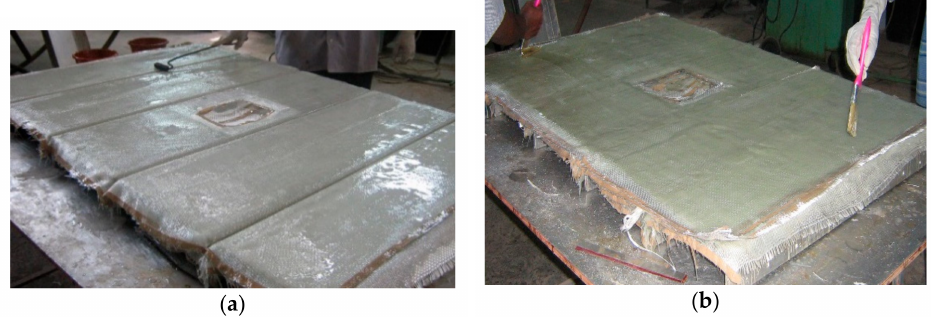
Figure 4. Casting of GFRP-stiffened composite plates. ( a ) Laying of the first three layers ( b ) Laying of last three